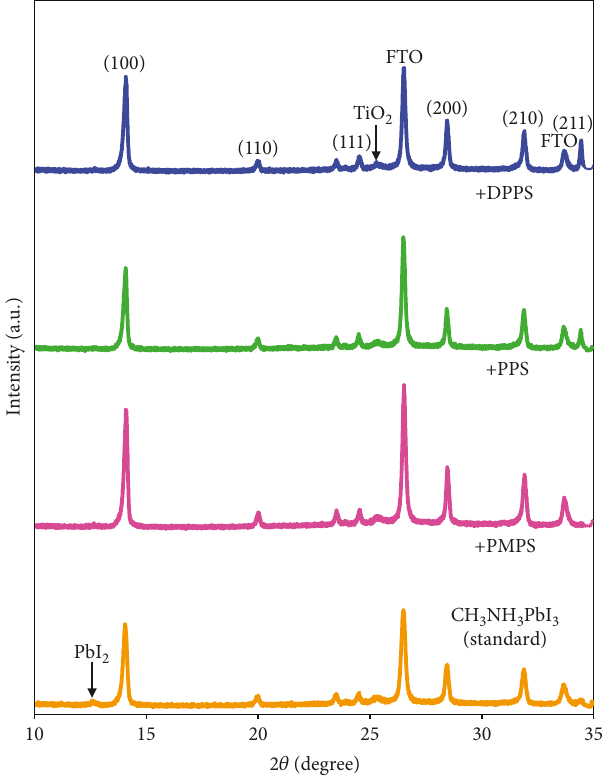
Figure 5: XRD patterns of CH